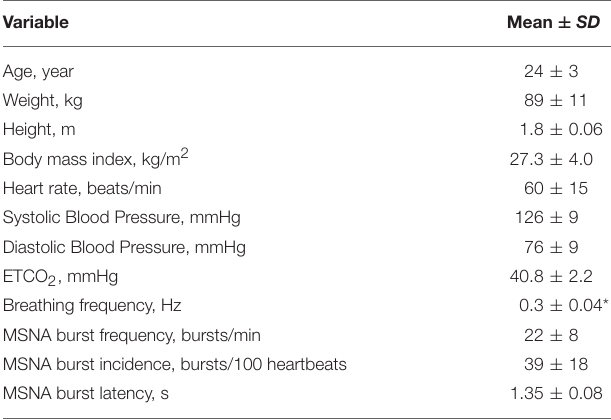
TABLE 1 | Baseline